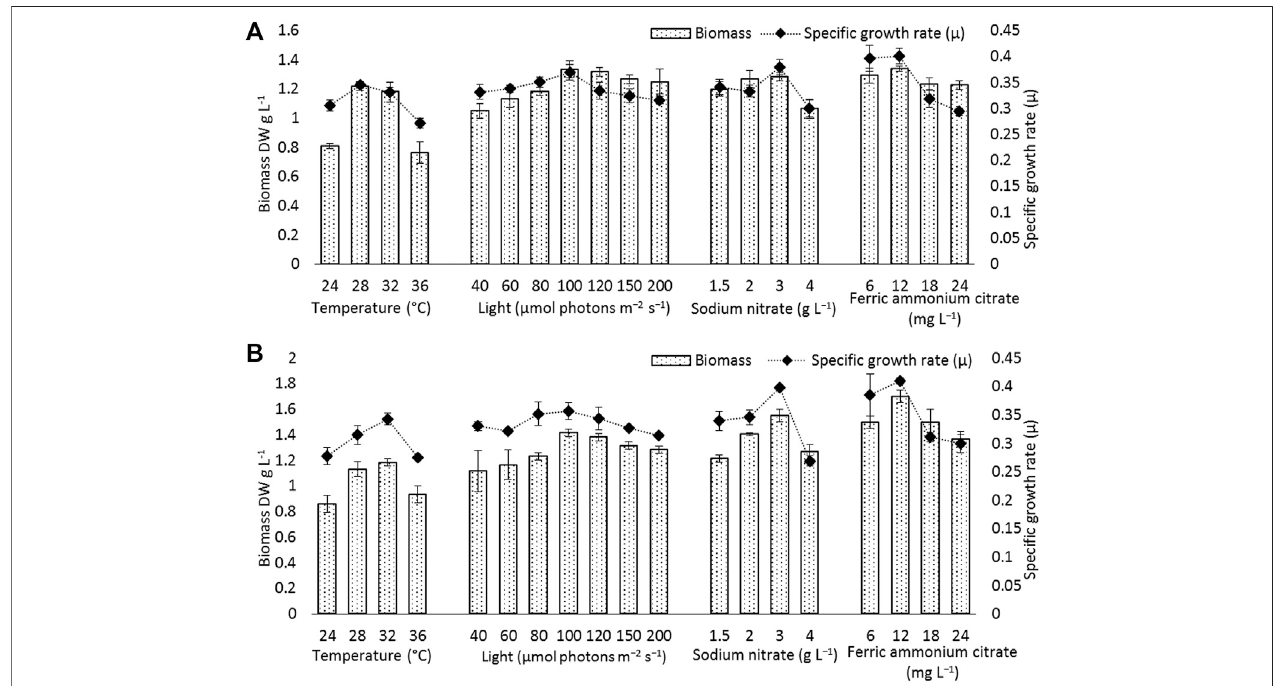
FIGURE4| Biomassandspeci fi cgrowthrateof (A) Euryhalinema sp., (B) Deserti fi lum sp.grownunderdifferenttemperature,light,andnutrientconditions(sodium nitrate and ferric ammonium citrate) at late exponential phase (12th day cultures). Error bars represent ± SD (n (cid:2) 3).